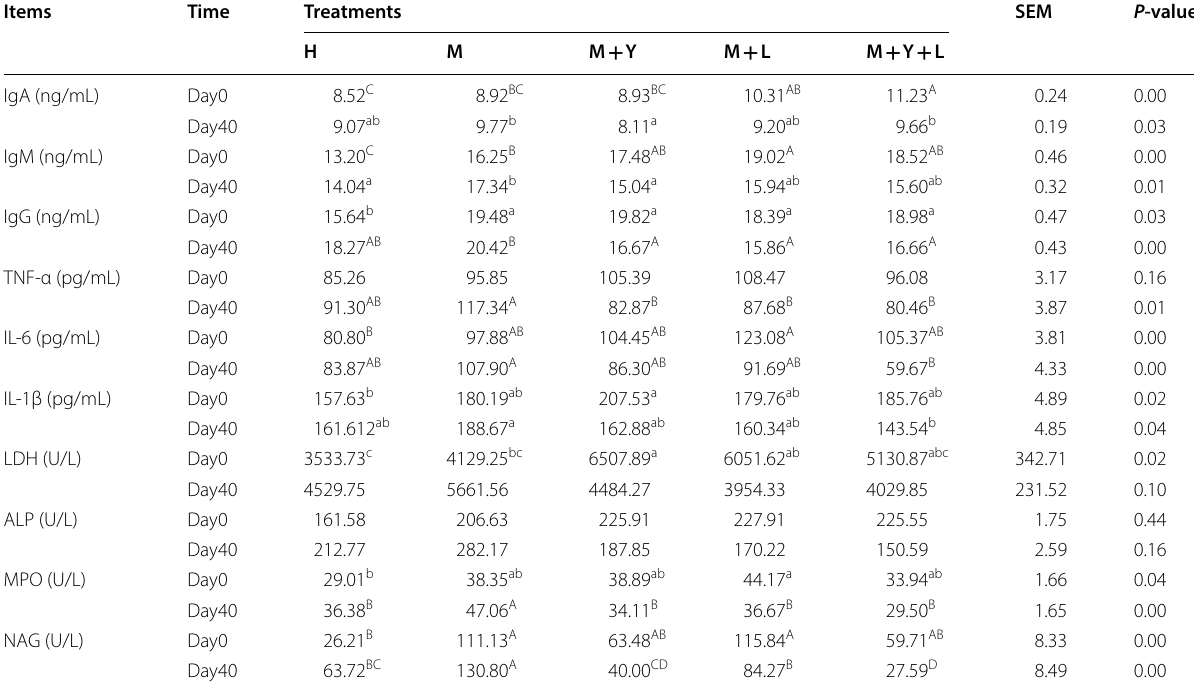
Table 2 The effect of treatments on serum concentration of immunoglobulin and milk concentration of inflammation cytokine and enzyme activity